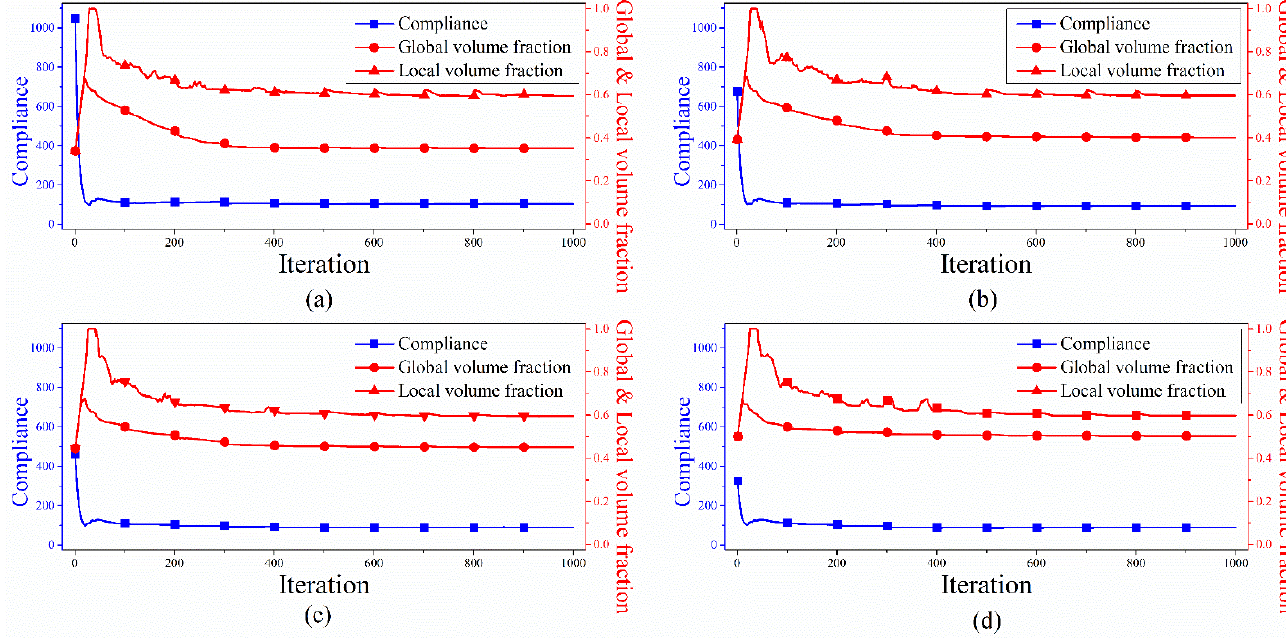
Figure 5. Iteration histories of compliance, global and local volume fraction from: ( a ) ψ = 0.35; ( b ) ψ = 0.40; ( c ) ψ = 0.45; ( d ) ψ = 0.50.